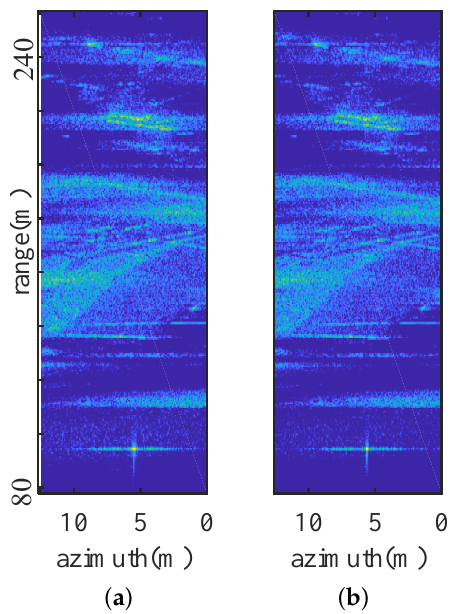
Figure 7. Local area autofocused using: ( a ) PGA, ( b ) SAPGA.